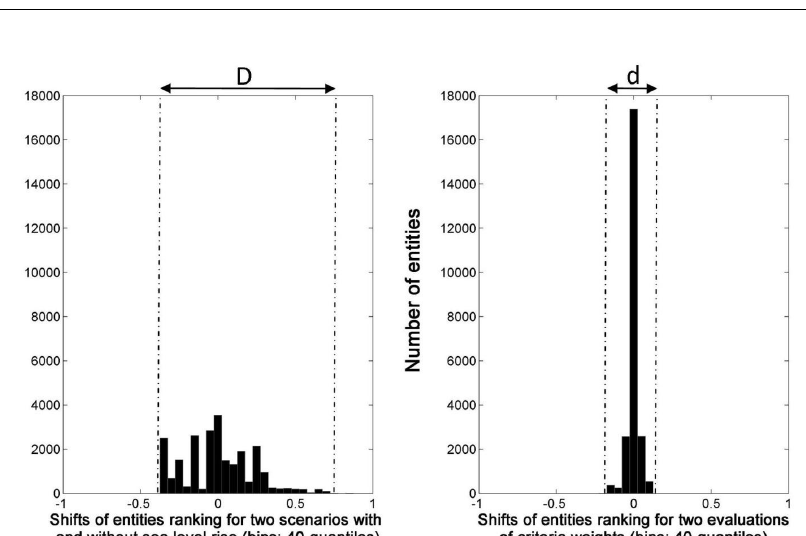
Figure 5: Sensitivity analysis performed for La Réunion to compare the redistribution of entity rankings when the criteria weightings in Table 5 change according to the sea level rise (right) and trend scenarios (left). On the right, the criteria are considered either of equal weight or as in Table 5. This corresponds to the maximum acceptable range of criteria weighting. The largest spread in the left-hand histogram (D > d) shows that considering two scenarios causes more changes in entity ranking than modifying the criteria weights in Table 5. This sensitivity analysis is used to prepare the qualitative assessment of uncertainties in Table